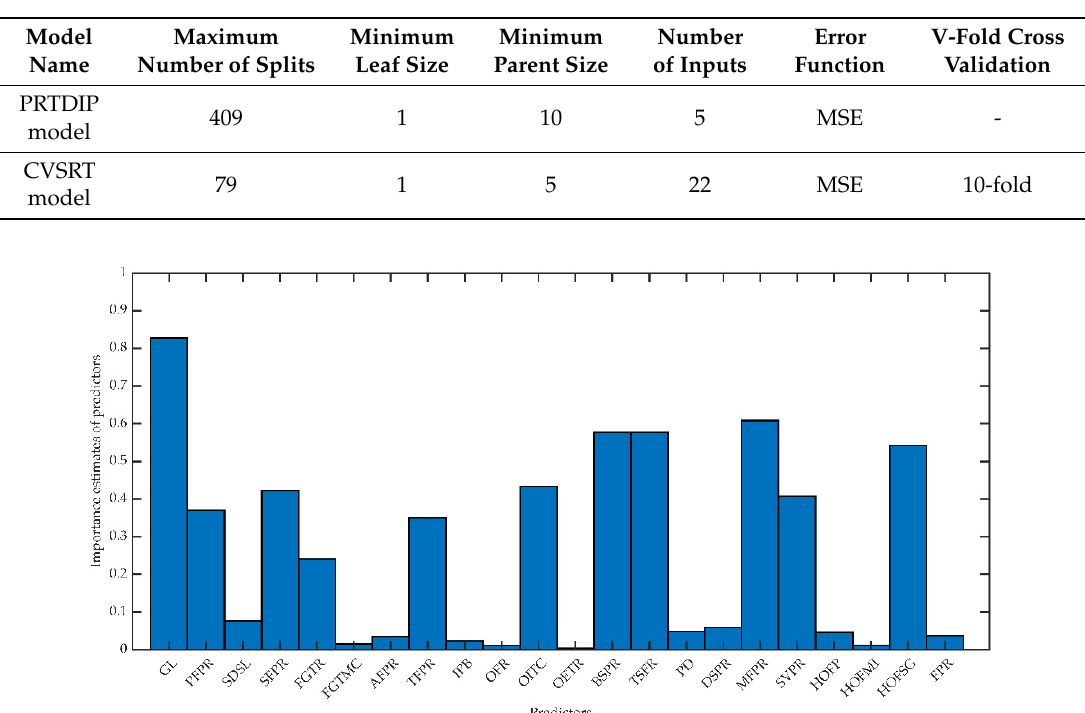
Figure 13. Importance estimates of predictors with regression trees for thermal energy production.